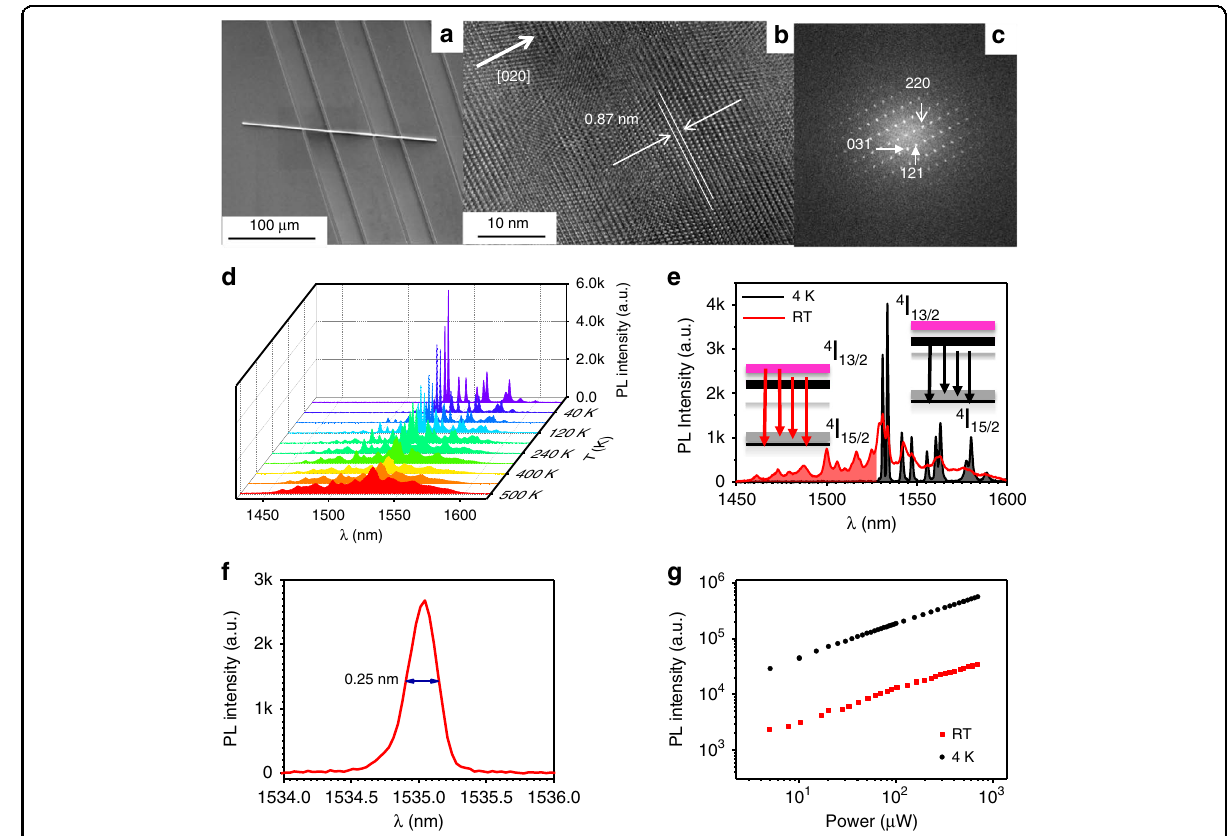
Fig. 1 Material characterization and spectral characterization of a single ECS nanowire. a SEM image of a single nanowire on a substrate with parallel grooves ( a , scale bar: 100 µm). b HRTEM of ECS single crystal (scale bar: 10 nm) and c the lattice diffraction pattern. PL properties of an ECS nanowire in the NIR-IIB bio-window pumped by 980 nm diode laser. d PL spectra from 4 to 500 K. e Comparison of PL spectra at 4 K and room temperature showing temperature-dependent population change and the corresponding PL spectral changes forming the foundation of temperature sensing mechanism. f Spectrum of a single Stark sub-peak originated from 4 I 13/2 levels at 4 K. g Power dependence of integrated emission intensity originated from 4 I 13/2 levels at 4 K and the room